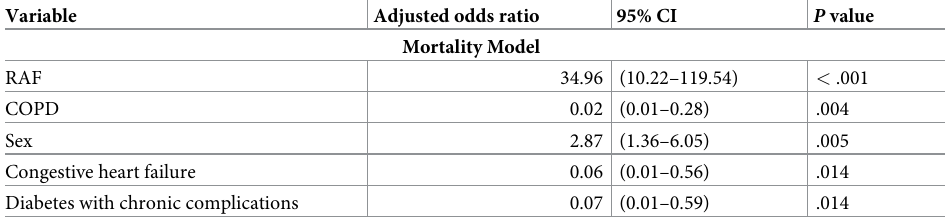
Table 4. Prognostic Model for Mortality in Hospitalized RT-PCR-Positive COVID-19 Patients from Deep Learn- ing